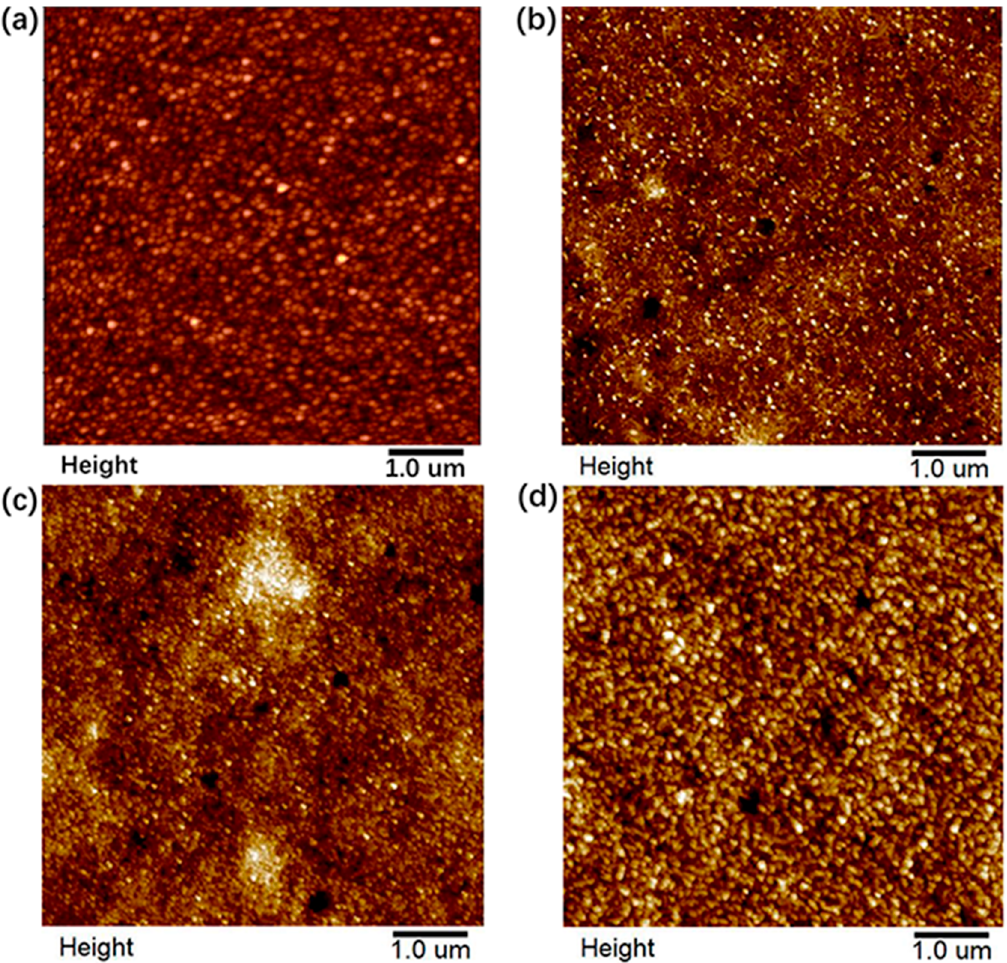
Figure 1. Atomic force microscopy (AFM) images of ITO/ZnO/CdSe/CdTe/ZnTe with different ZnTe thickness. ( a ) Without ZnTe; ( b ) 10 nm ZnTe; ( c ) 20 nm ZnTe; ( d ) 50 nm ZnTe.